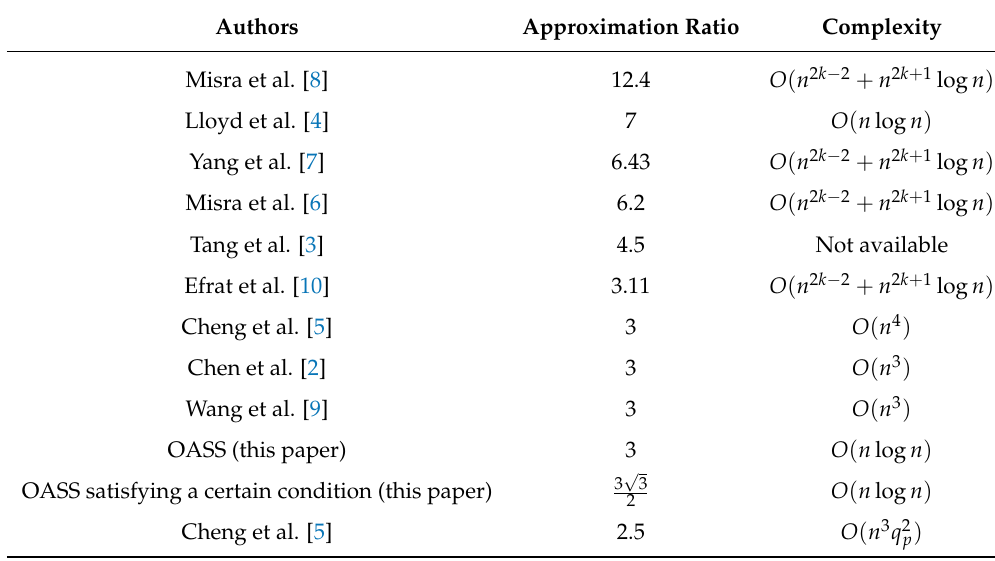
Table 1. Comparison of some contemporary heuristic algorithms for connectivity restoration in Wireless Sensor Networks (WSNs) through Relay Nodes (RNs) placement.